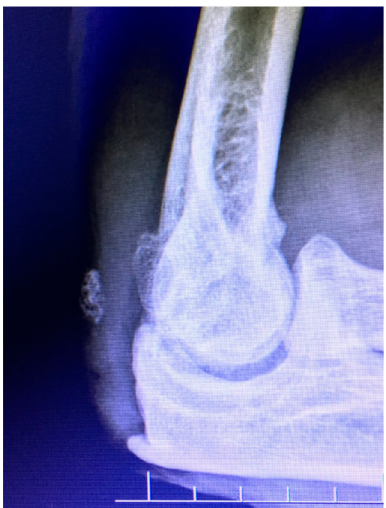
Figure 2. Lateral radiograph of the elbow in a healthy patient.